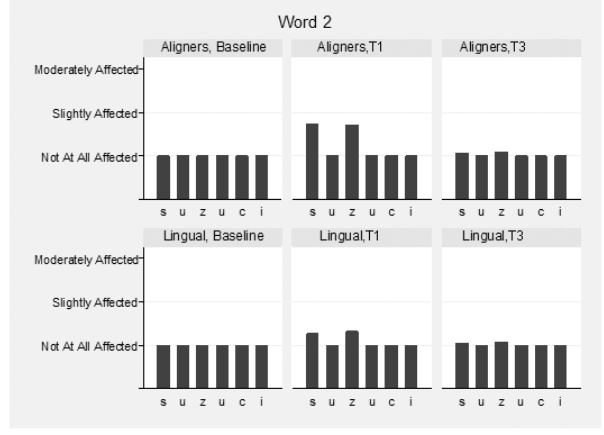
Figure 5. Speech articulation (2nd word: “Suzuki”) by group and time.